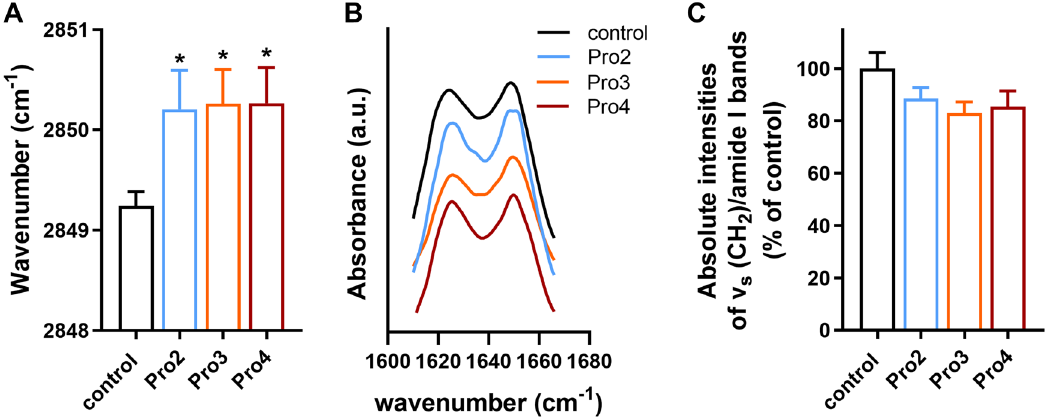
Figure 4. Interactions of the studied enhancers Pro2, Pro3, and Pro4 with human stratum corneum examined by infrared spectroscopy: methylene symmetric stretching wavenumbers indicative of decreased lipid chain order ( A ), amide I band with no significant effect on protein conformation ( B ), and relative intensities of the methylene symmetric stretching band to amide I band indicating no significant lipid extraction ( C ). Data are presented as the means ± SEM; n ≥ 3. *Statistically significant difference compared to control (60% PG without enhancer) at p <